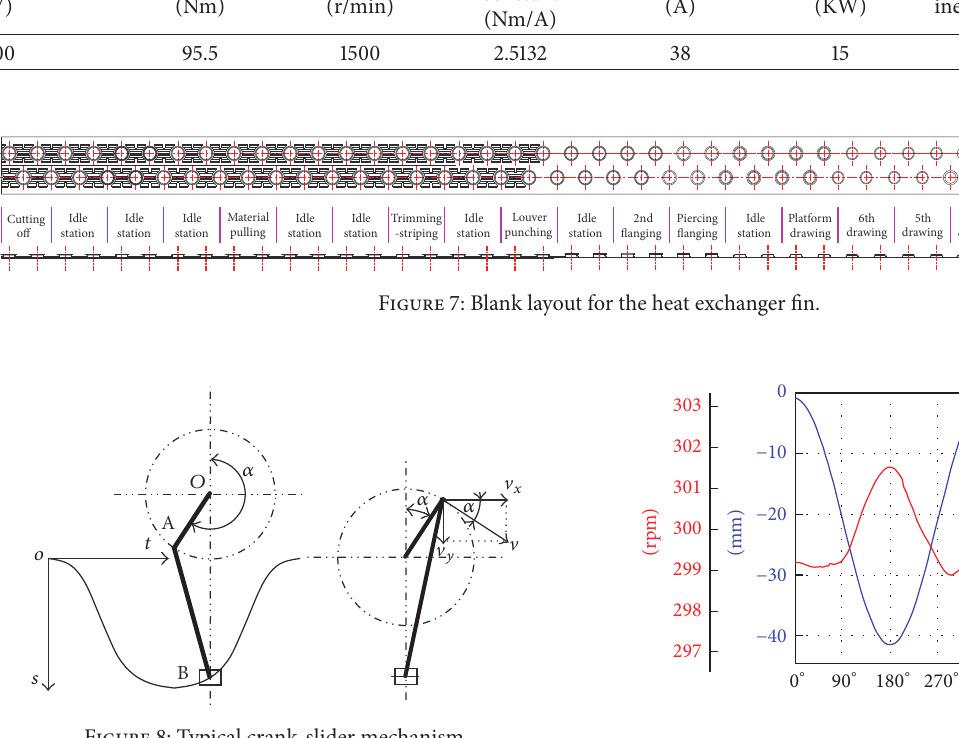
Figure 8: Typical crank-slider mechanism.